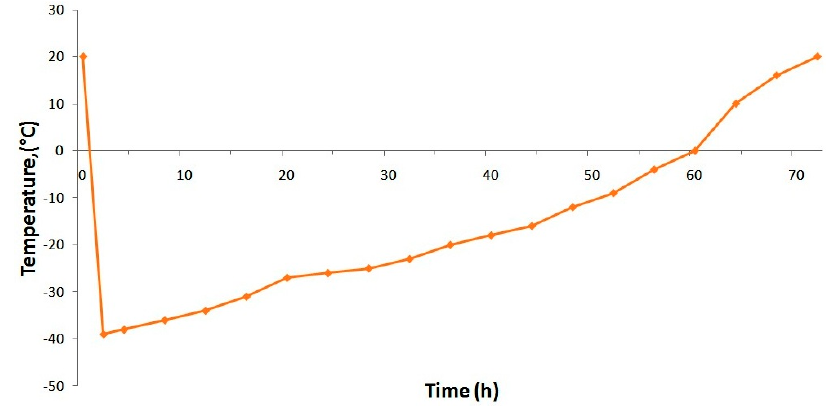
Figure 2. Temperature curve for formulation during drying.